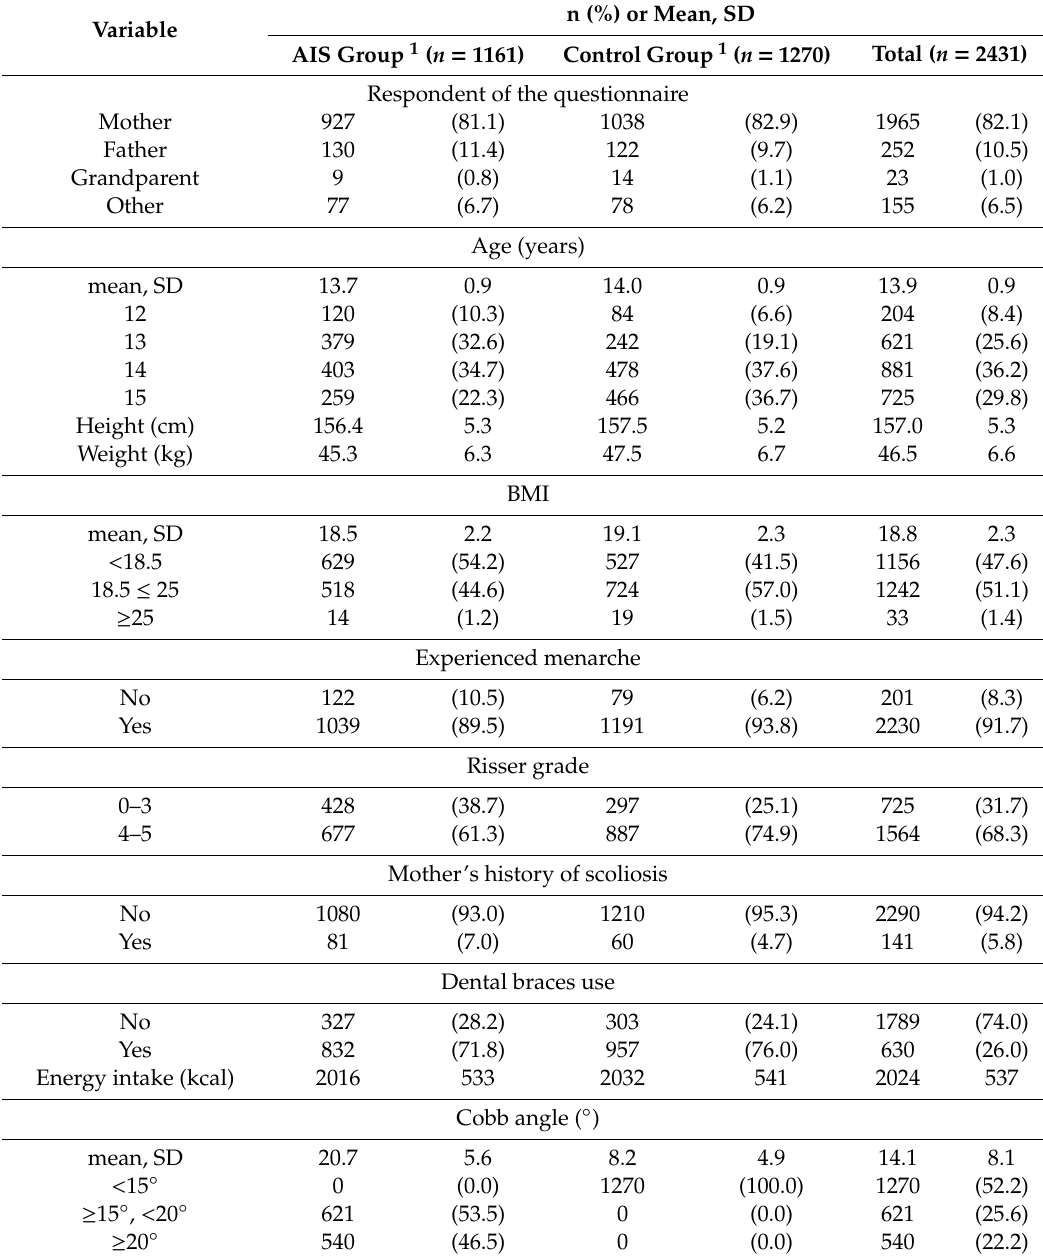
Table 1. Characteristics of the